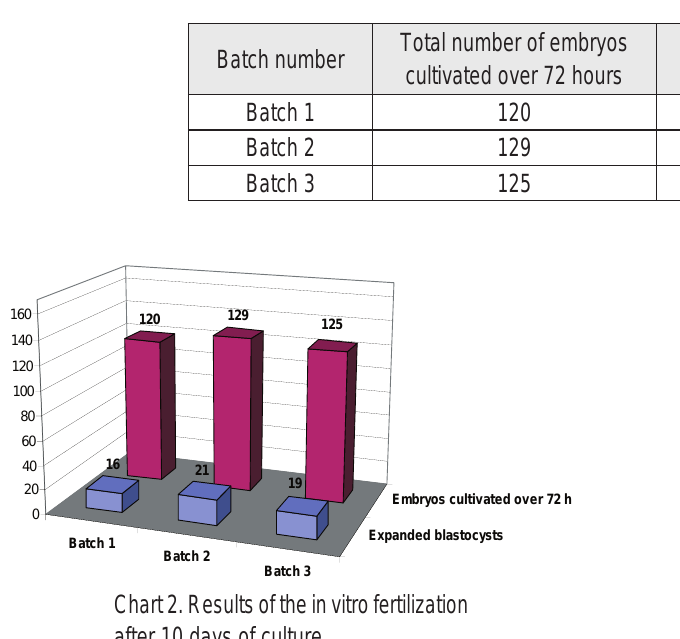
Table 2. Results of the in vitro fertilization after 10 days of culture